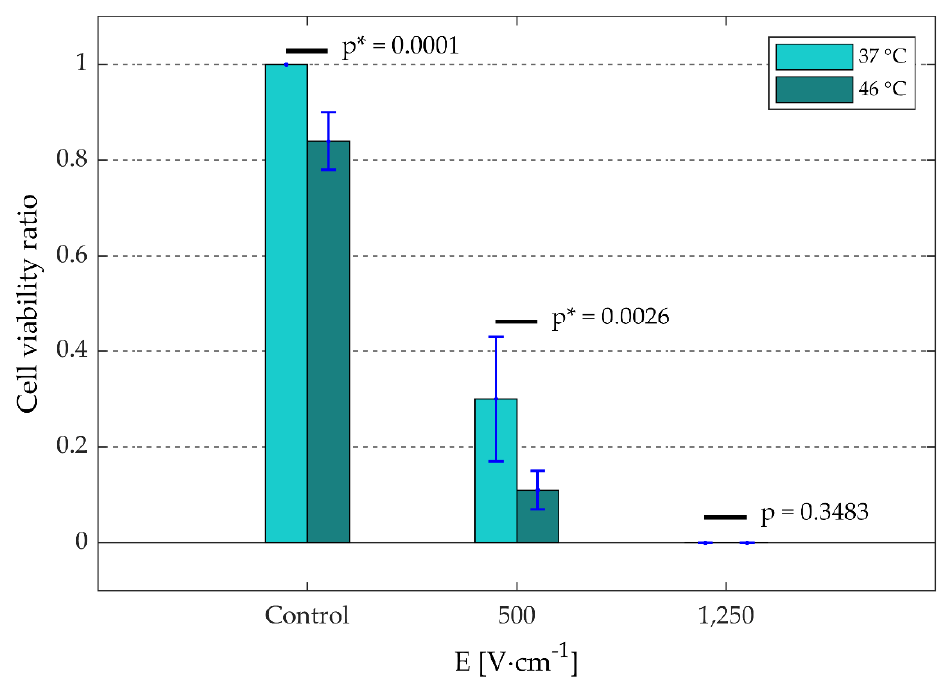
Figure 10. The cell viability ratio (n = 3; including ± SD) of cell suspensions as a function of electric-field strength (E [V ⋅ cm −1 ]) and target temperature with respect to the control at 37 °C. For both control and 500 V ⋅ cm −1 , the cell viability ratio at 46 °C significantly differ from the ratio at 37 °C (p ≤ 0.0026; * indicates significant difference). Please note that during the control/treatments, the culture medium was used in the cell suspension.